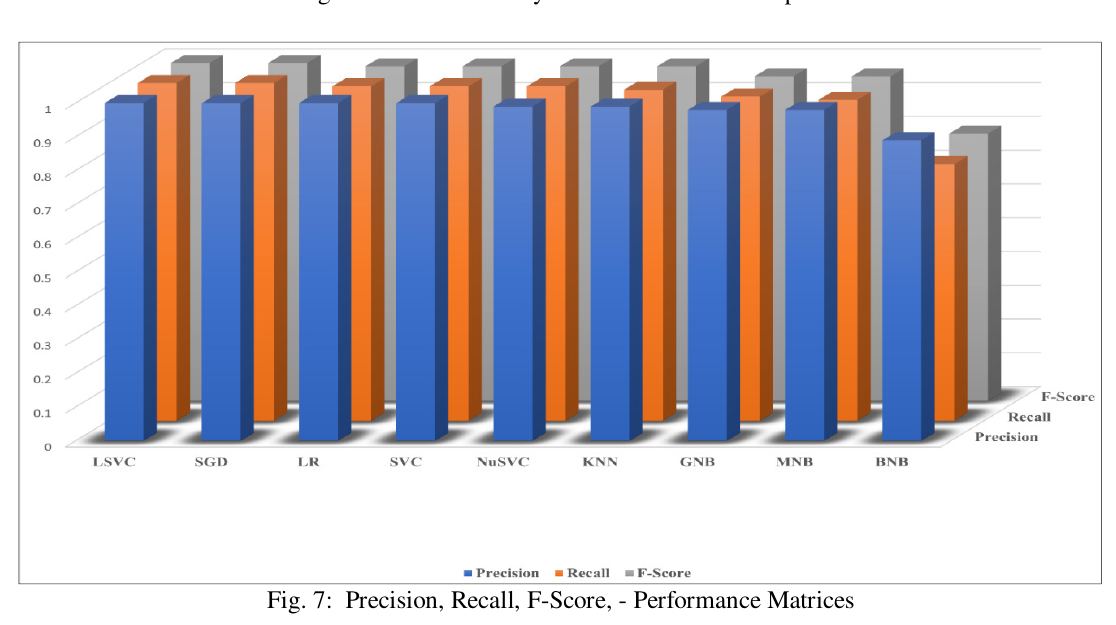
Fig. 7: Precision, Recall, F-Score, - Performance